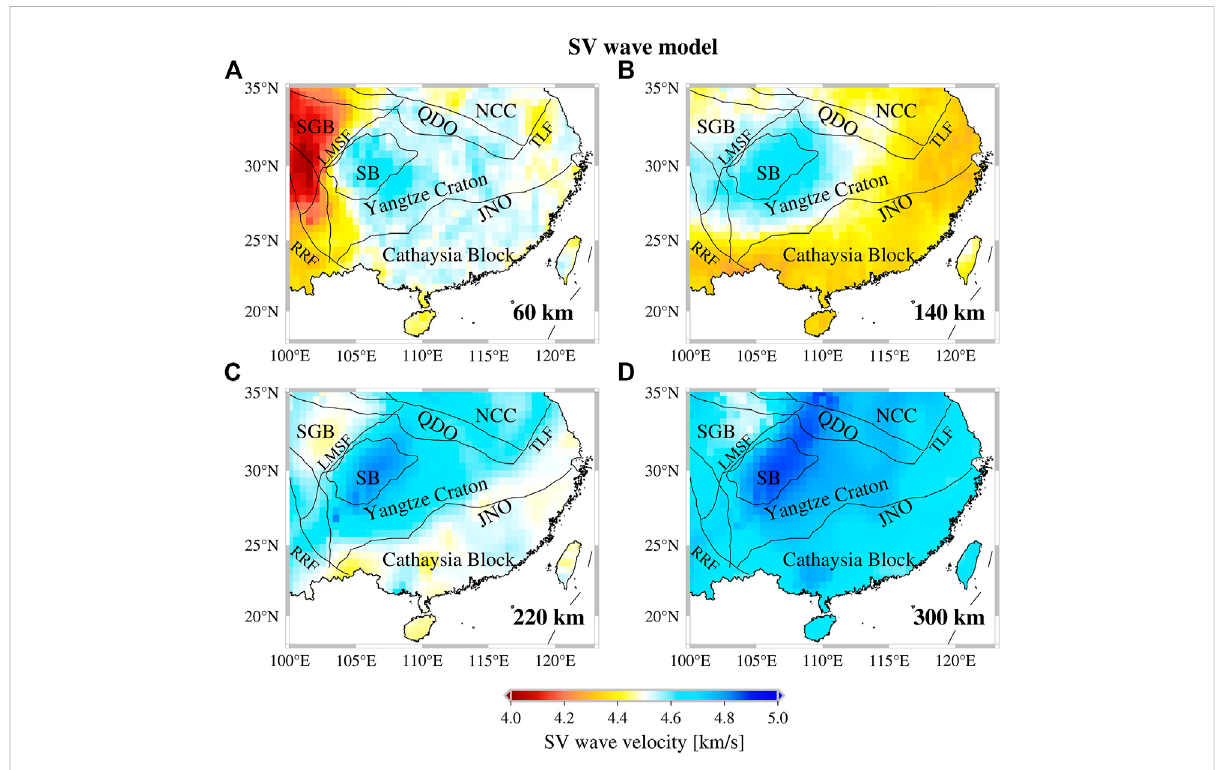
FIGURE 5 SV wave velocity of the mantle component of SREM-SC at depths of (A) 60 km (B) 140 km (C) 220 km, and (D) 300